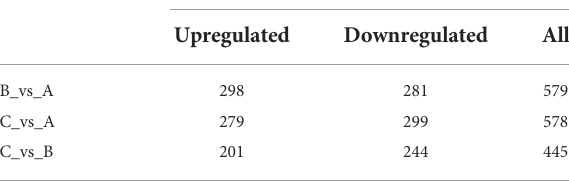
TABLE 5 Statistical table of protein quantitative difference results (A: Control group; B: Primary stimulation group; C: Secondary stimulation